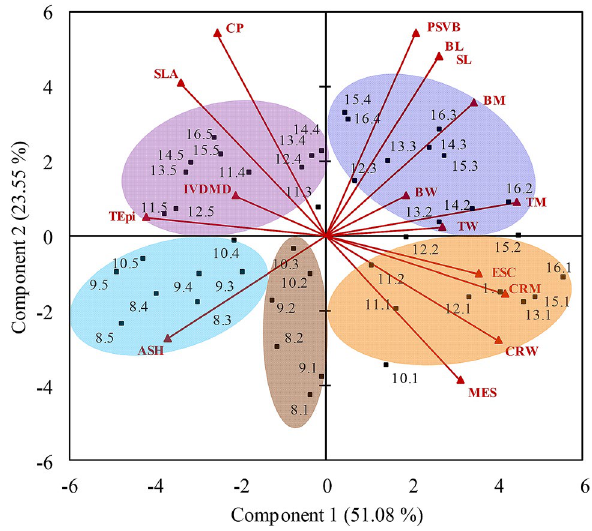
Figure 5. Biplot PC1 × PC2 for morphological (blade length (BL), segment length (SL), total width (TW), blade width (BW), central rib width (CRW), total mass (TM), blade mass (BM), central rib mass (CRM) and specific leaf area (SLA)), anatomical (sclerenchyma (SCL), parenchymatic sheath of vascular bundles + vascular tissue (PSVB), mesophyll (MES) and total epidermis (TEpi)) and nutritive value (crude protein (CP), in vitro dry matter digestibility (IVDMD) and ash (ASH)) characteristics of leaves with contrasting levels of insertion on the tiller axis (phytomers) of Napier elephant grass. Points represent the phytomers with their respective segments and arrows represent the vector for each variable.